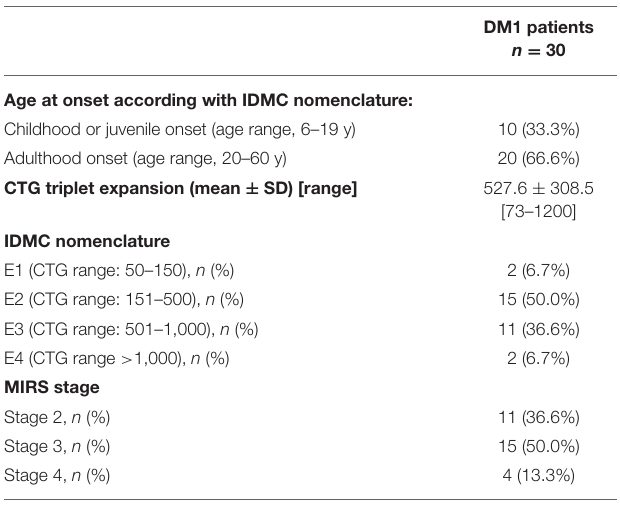
TABLE 2 | Principal genetic and clinical characteristics of patients with